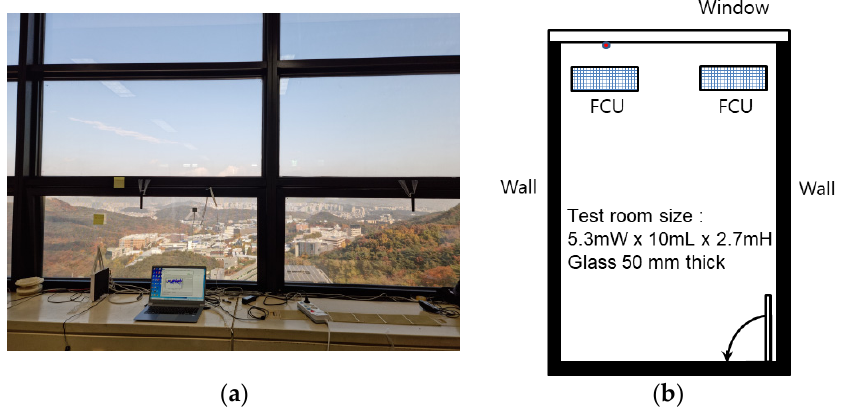
Figure 1. Photograph ( a ) and schematic ( b ) of the test